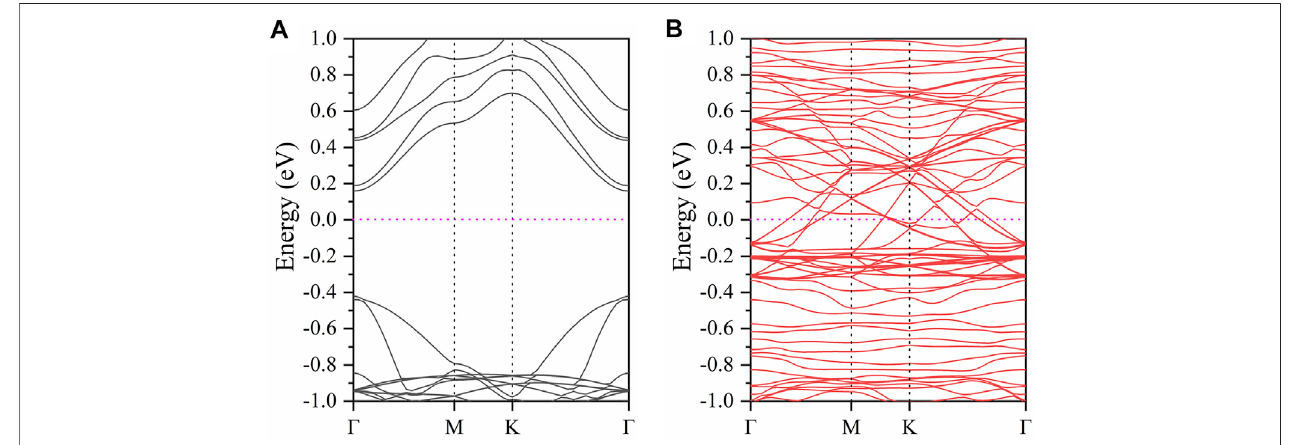
FIGURE3| BandstructureoftheCrGeTe 3 /NiOheterojunctionintheFM2state. (A) and (B) representthespin-upandspin-downchannels,respectively.TheFermi level is set to zero.